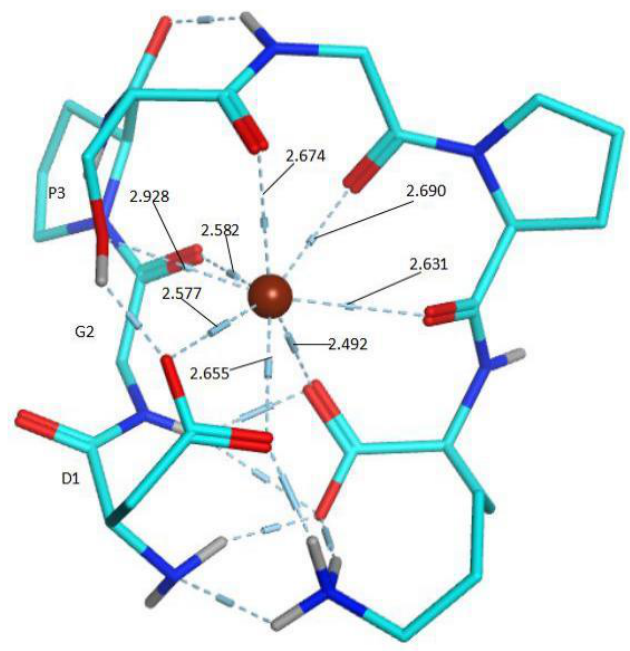
Figure 8. Snapshots of molecular dynamic simulation of DGPSGPK-Ca.